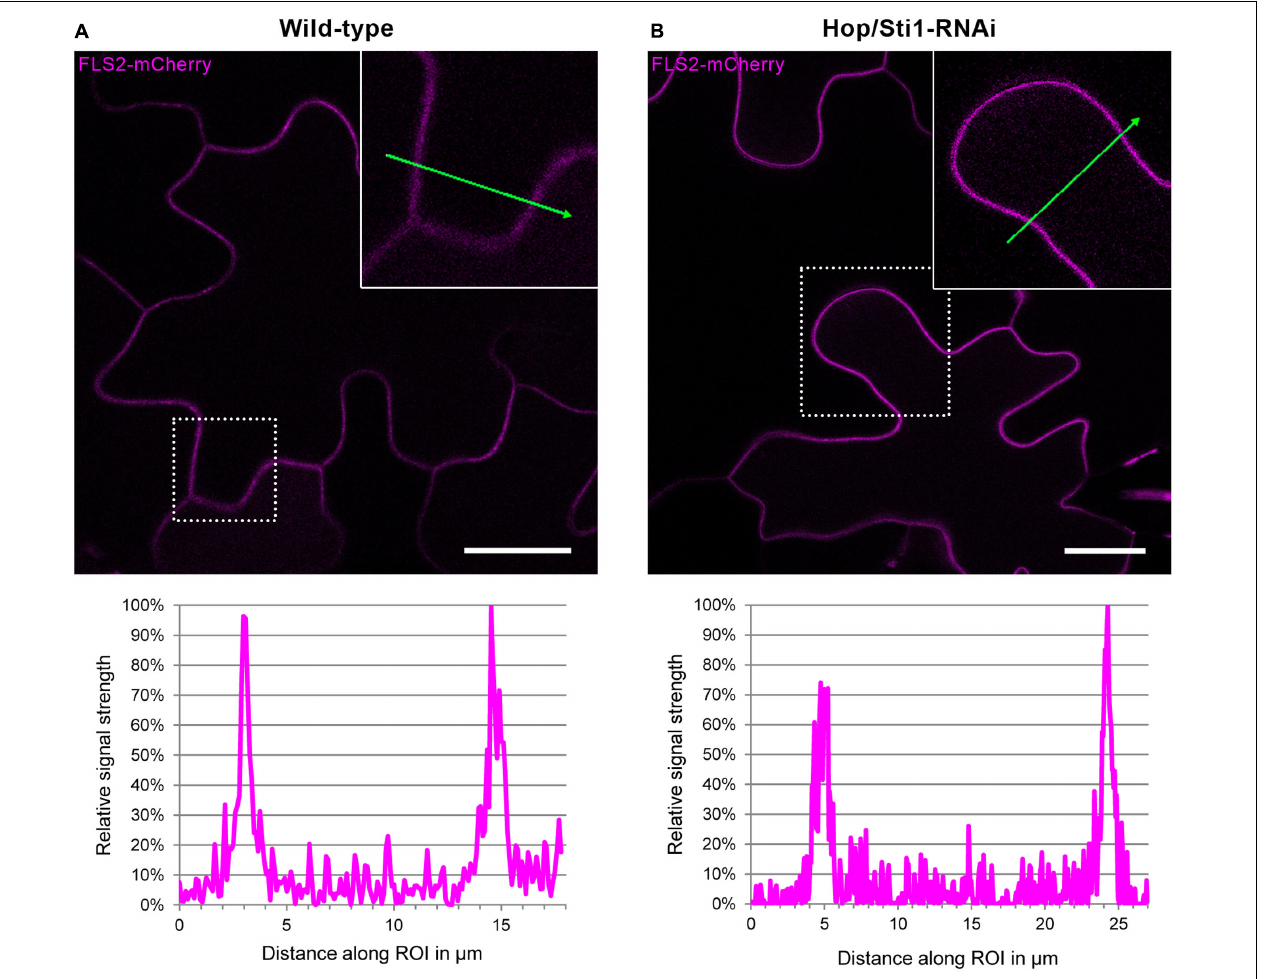
FIGURE 4 | Assessment of potential FLS2-mistargeting in Hop/Sti1-RNAi lines. (A) Wild-type Nicotiana tabacum transiently expressing FLS2-mCherry, fluorescence signal intensities measured along the ROI (green arrow) are depicted in the diagram below, showing maxima at the plasma membranes and lower basal signal in the cytoplasmic areas. (B) Hop/Sti1-RNAi plants transiently expressing FLS2-mCherrry, fluorescence signal intensities depicted analogous to (A) . Scale bars represent 20 µ